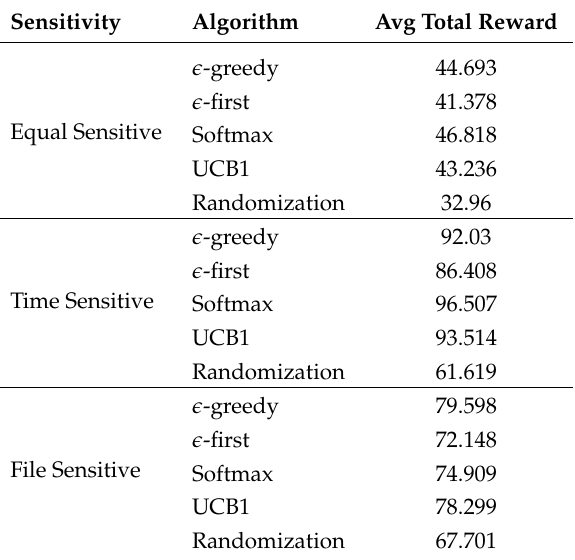
Table 2. Number of disk images successfully